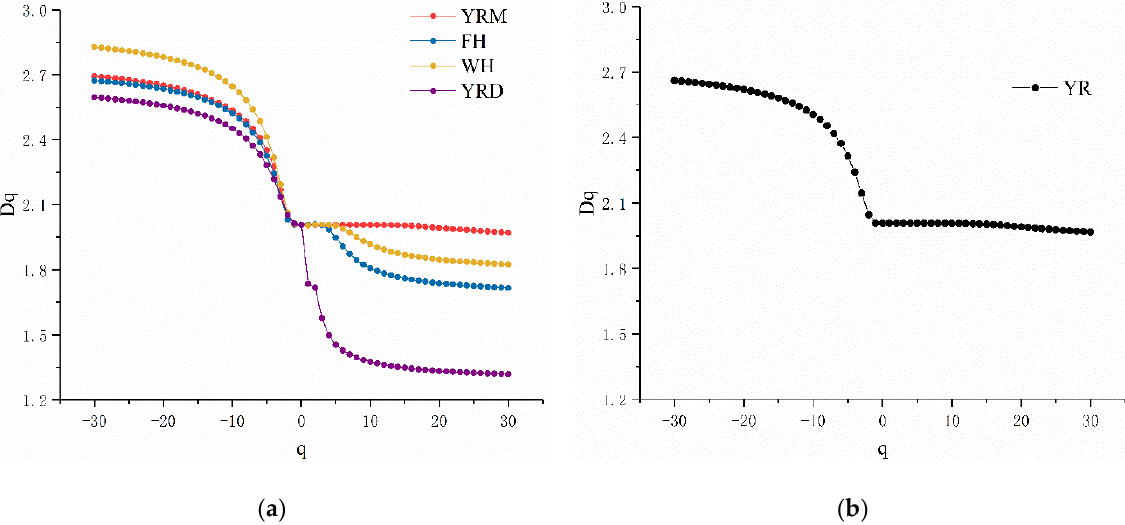
Figure 6. The relationships between the generalized multifractal dimension D q and the moment order q of ( a ) The Yellow River Mainstream Basin (YRM), the Fenhe River Basin (FH), the Weihe River Basin (WH), the Yellow River Downstream Basin (YRD), and ( b ) The Yellow River Basin (YR).